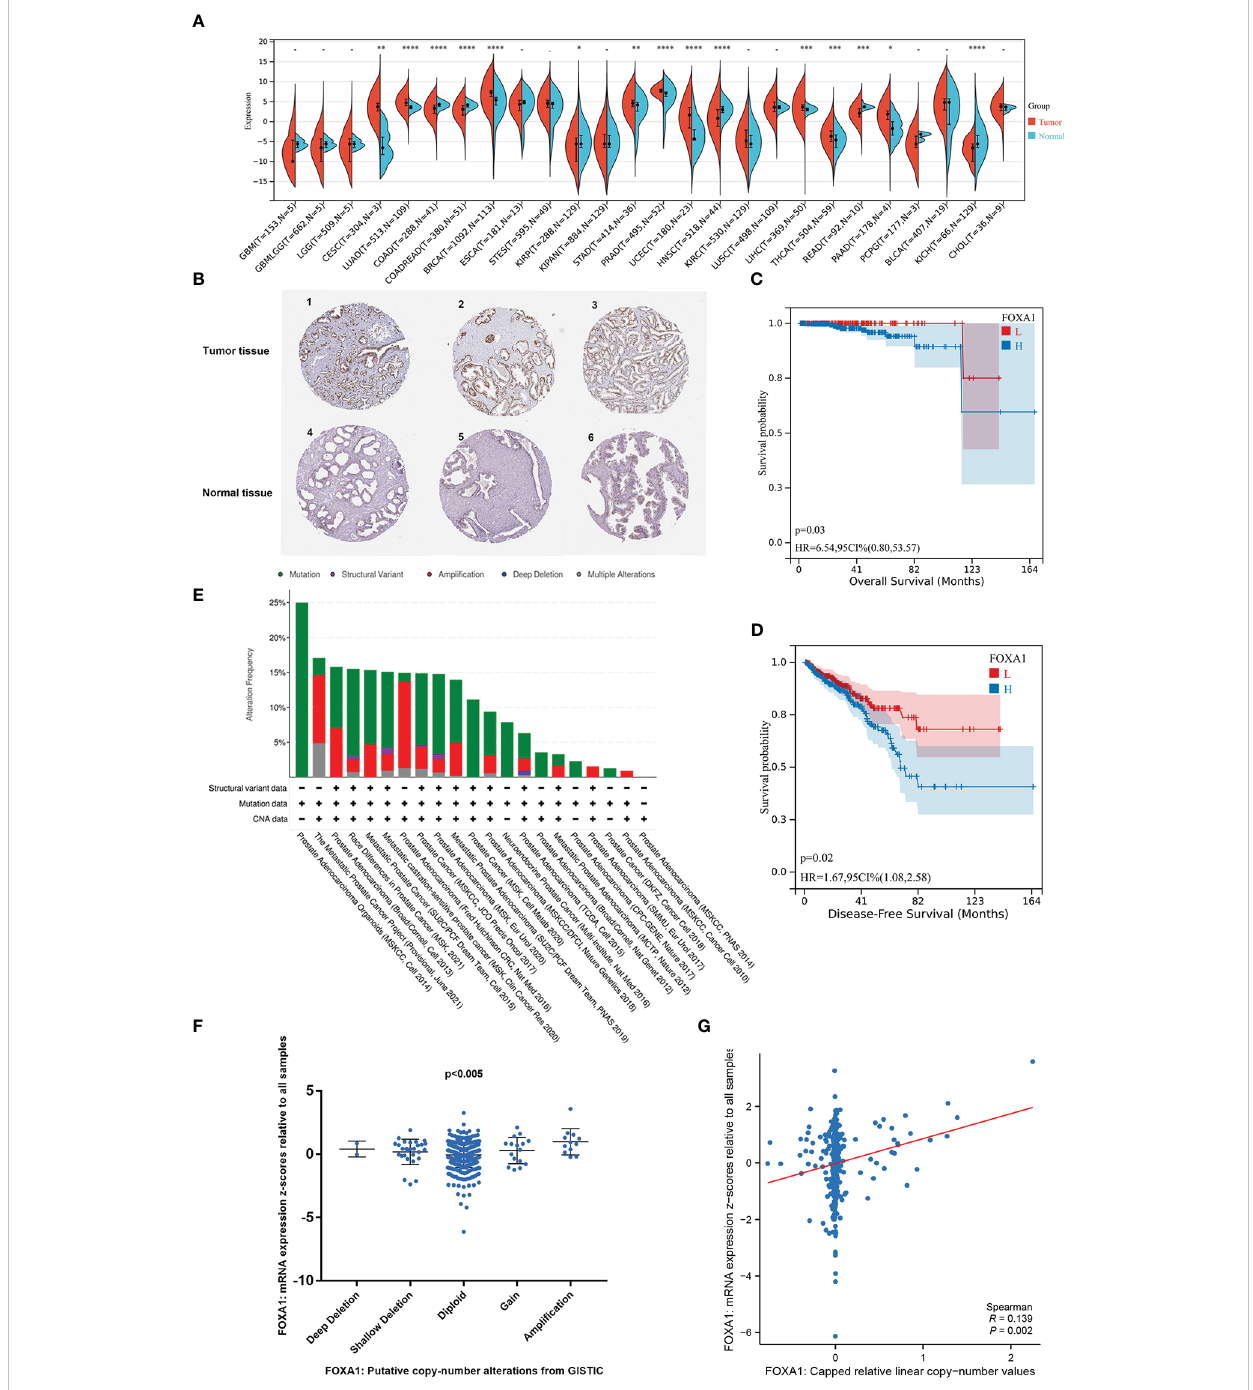
FIGURE 2 The carcinogenic role of FOXA1 in prostate cancer. (A) Expression distribution of FOXA1 in pan-cancer tissues. (B) Validation of the expression of FOXA1 on the translational level by the Human Protein Atlas database (immunohistochemistry). (C, D) Kaplan – Meier survival analysis of the relationship between FOXA1 expression and cancer patient prognosis in the TCGA cohort (H = FOXA1 high expression, n = 247; L = FOXA1 low expression, n = 245). (E) The distribution of FOXA1 genomic alterations in 21 prostate studies is shown on a cBioPortal OncoPrint plot. (E, F) The association between FOXA1 copy number and mRNA expression is displayed in the dot plot (F) and correlation plot (G) by cBioPortal. *P <0.05, **P < 0.01, ***P < 0.001,